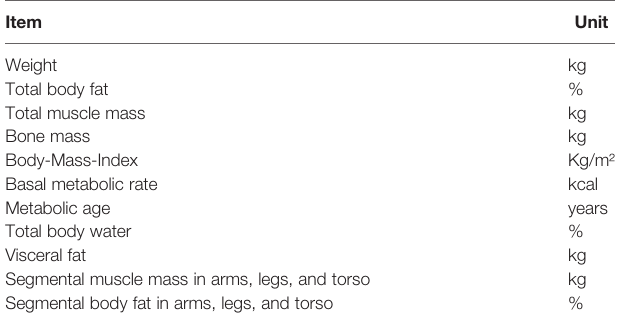
TABLE 2 | Spiroergometry.